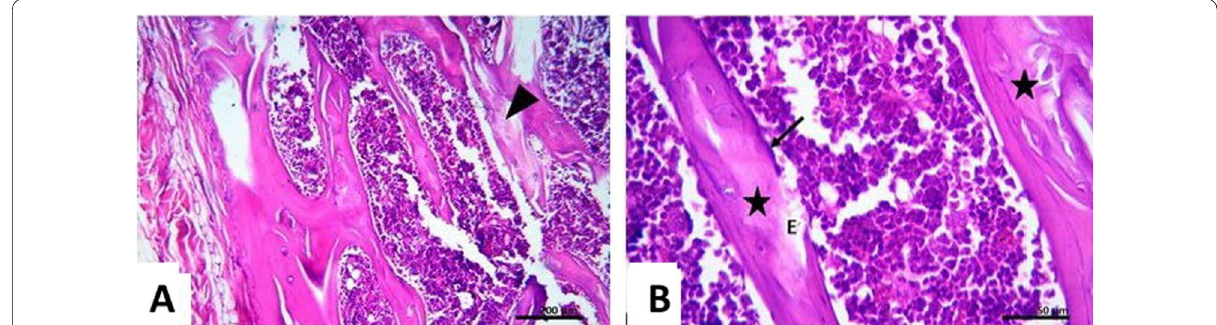
Fig. 8 H&E stained sections of the lower femur of tamoxifen/risperidone/ketamine treated rat shows localized areas of faint staining of bone matrix and eroded areas of bone could be seen which shows improvement compared to risperidone/ketamine treated group ( A H&E